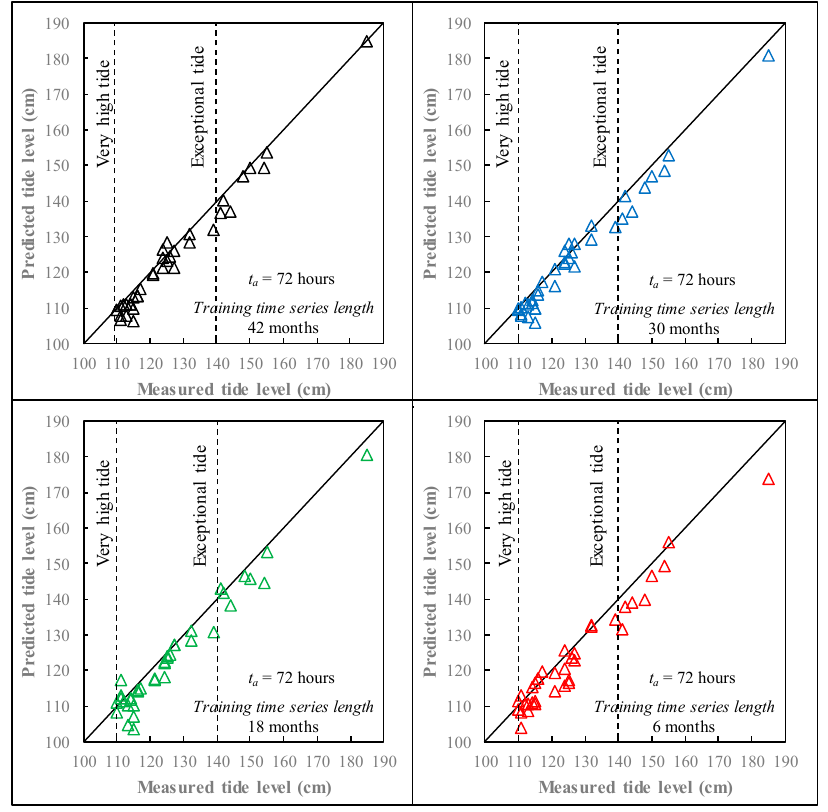
Figure 5. Comparison between measured and predicted storm tide—Sensitivity analysis to the training time series length. Table 2. Forecasting performance—Sensitivity analysis to the training time series length. Time Series Length for the